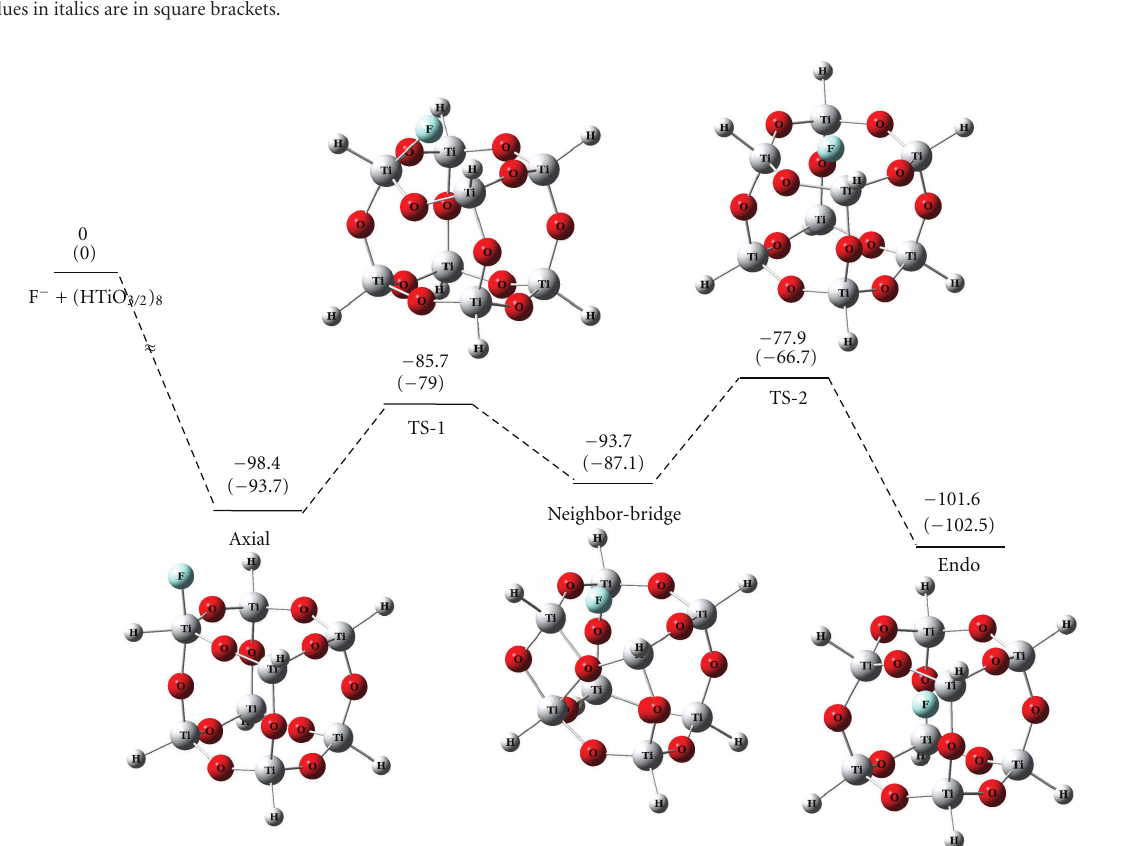
Figure 6: The potential energy surface (kcal/mol) of the insertion reaction of F − into Ti-T 8 with the structures of some stationary points at the B3LYP/6-311+G(d)+ZPC and HF/6-311+G(d)+ZPC (in parentheses)